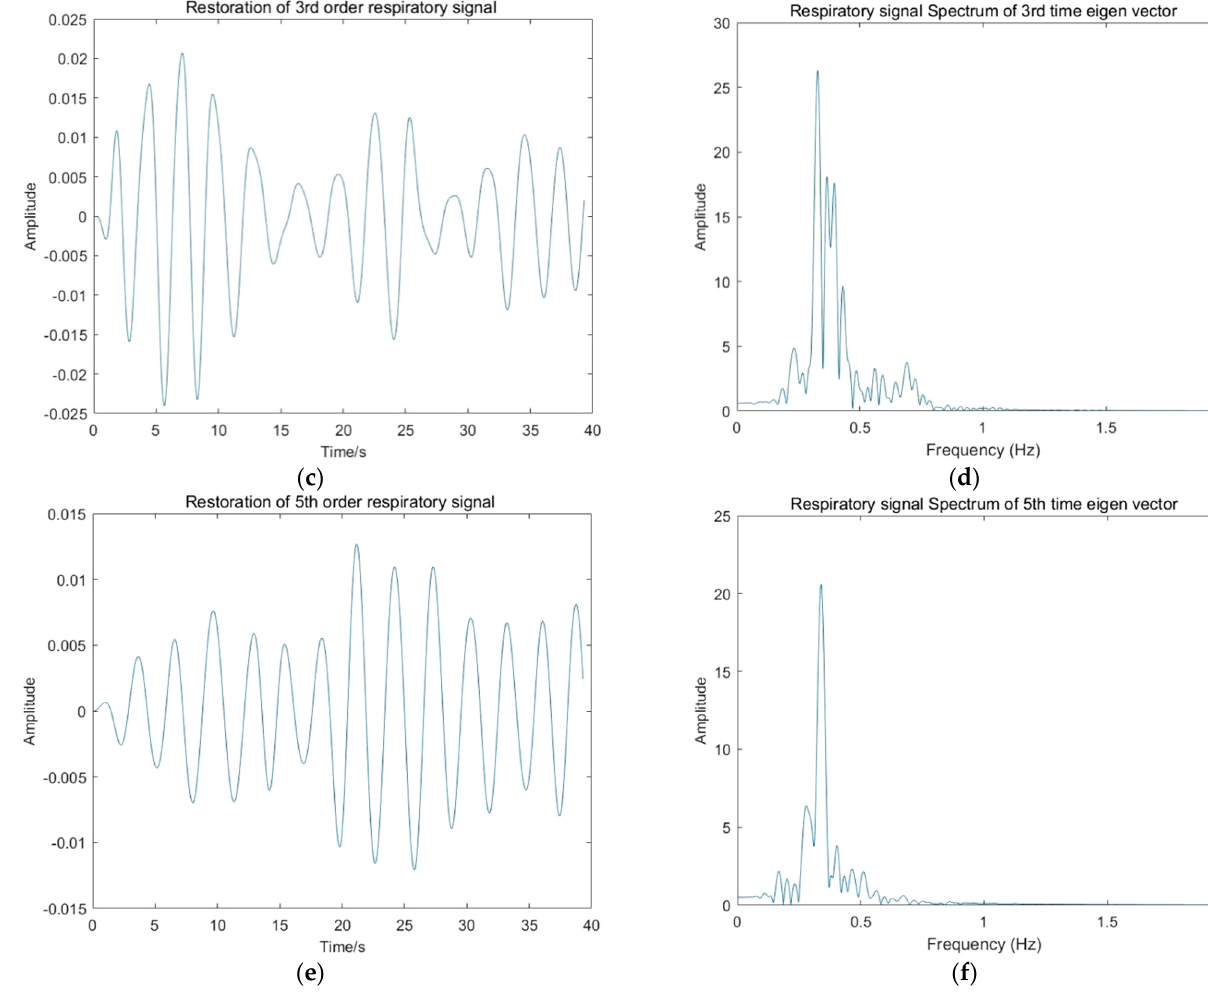
Figure 19. Respiratory signal restoration result: ( a ) Restoration of first order respiratory signal; ( b ) first order respiratory signal spectrum; ( c ) Restoration of third order respiratory signal; ( d ) third order respiratory signal spectrum; ( e ) Restoration of fifth order respiratory signal; ( f ) fifth order respiratory signal spectrum.